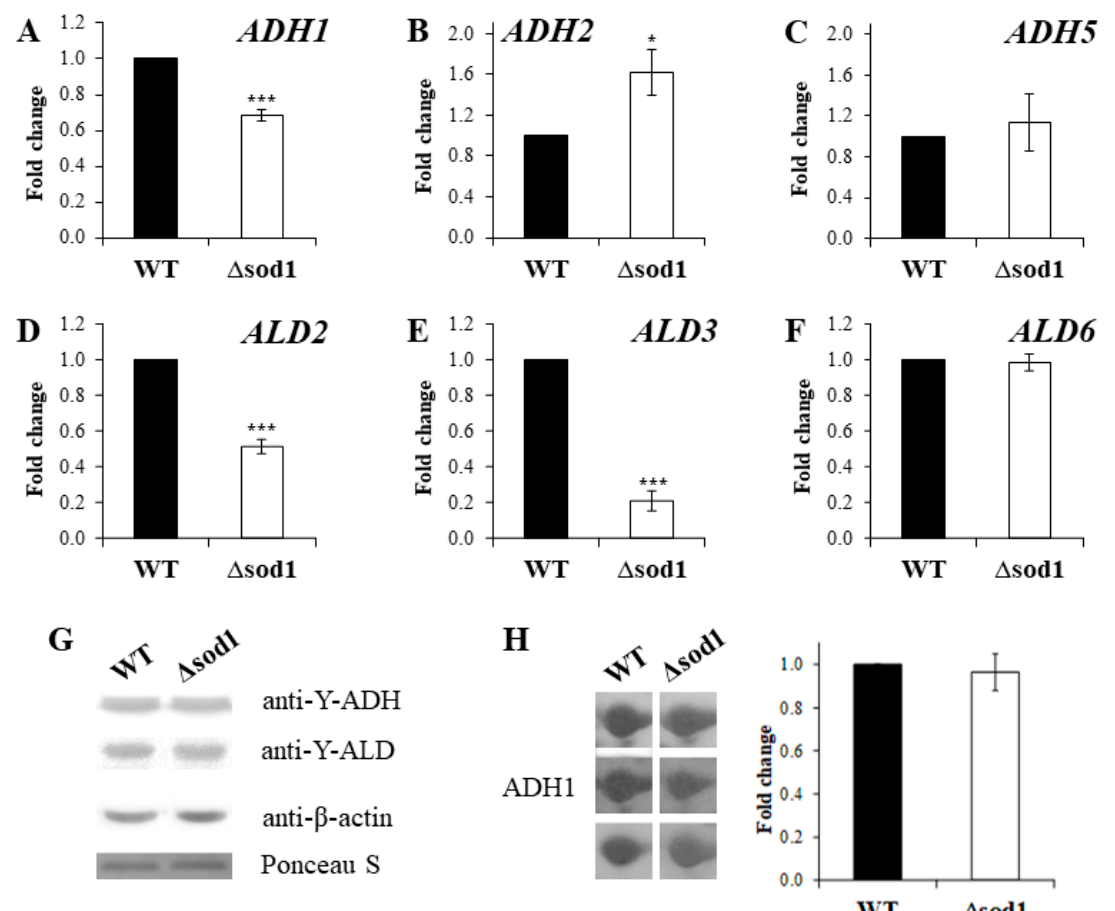
Figure 3. ADH and ALD gene expression and ADH and ALD protein content in the wild-type (WT) strain and ∆ sod1 mutant. ADH ( A – C ) and ALD ( D – F ) gene expression were performed by qPCR assay with TaqMan probes. The relative gene expression was calculated with a comparative C T method: the − ∆∆ C T method for comparison of individual gene expression between the WT and ∆ sod1 mutant. The results are presented as mean ± SD from three independent experiments. * p < 0.05, *** p < 0.001 as compared to the results for the WT strain. The ADH and ALD proteins were detected by the immunoblotting assay with the primary antibodies: anti-yeast alcohol dehydrogenase (1:5000), anti-yeast aldehyde dehydrogenase (1:5000), and anti- β -actin (1:5000) with the horseradish peroxidase-conjugated secondary antibodies (1:10,000 or 1:10,000) and a chemiluminescent substrate ( G ). Protein identification was performed by two-dimensional gel electrophoresis and then by liquid chromatography coupled to the mass spectrometer. The picture represents the results from three independent experiments ( H